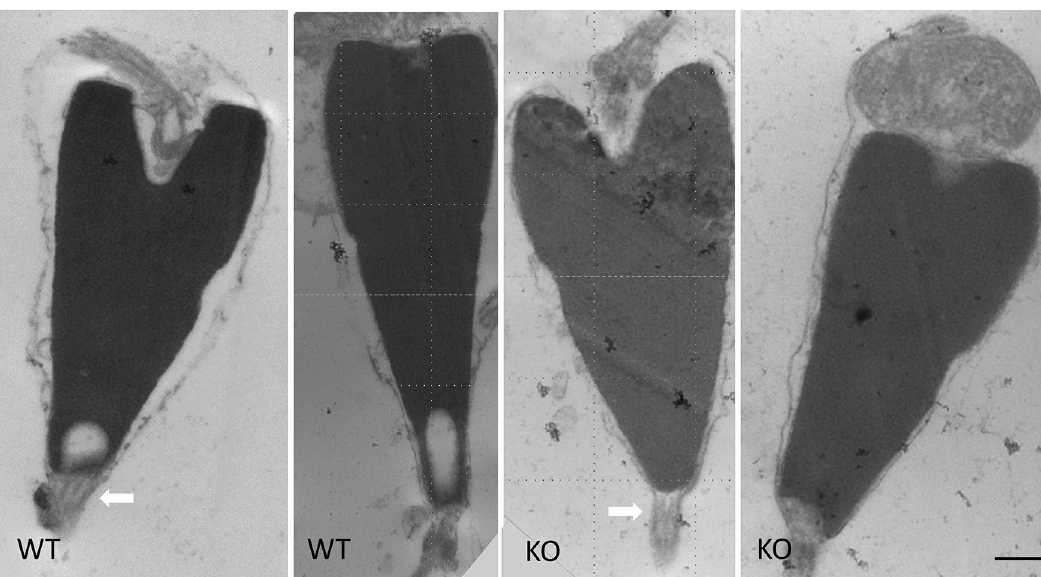
Figure 6. TEM of Wildtype and bindin-KO sperm following exposure to egg jelly that stimulates the acrosome reaction. Note the acrosomal process (white arrow) in both wildtype and bindin-KO. Scale bar = 0.5